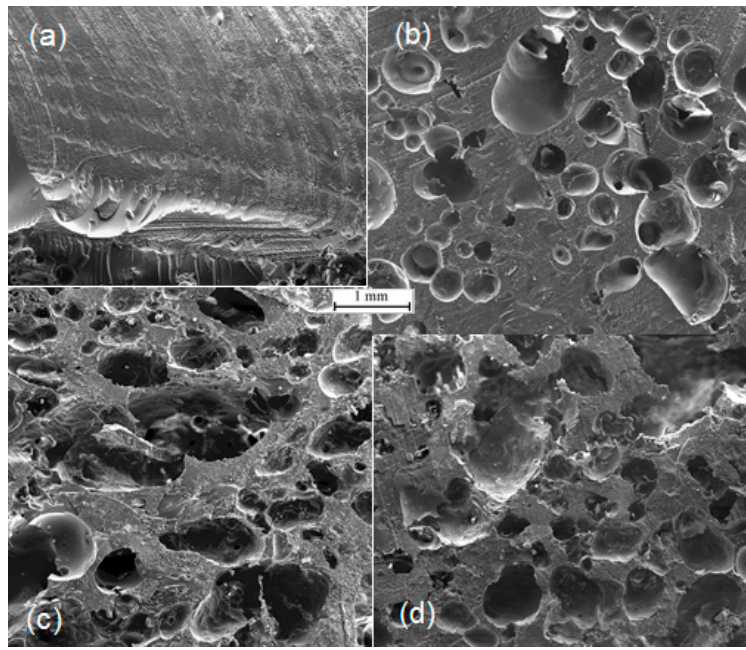
Figure 1. The SEM images of foams consisting of pristine AESO material ( a ); as well as AESO foam reinforced with 2.0% cellulose fibres ( b ); 3.0% cellulose fibres ( c ); and 4.0% cellulose fibres ( d ).